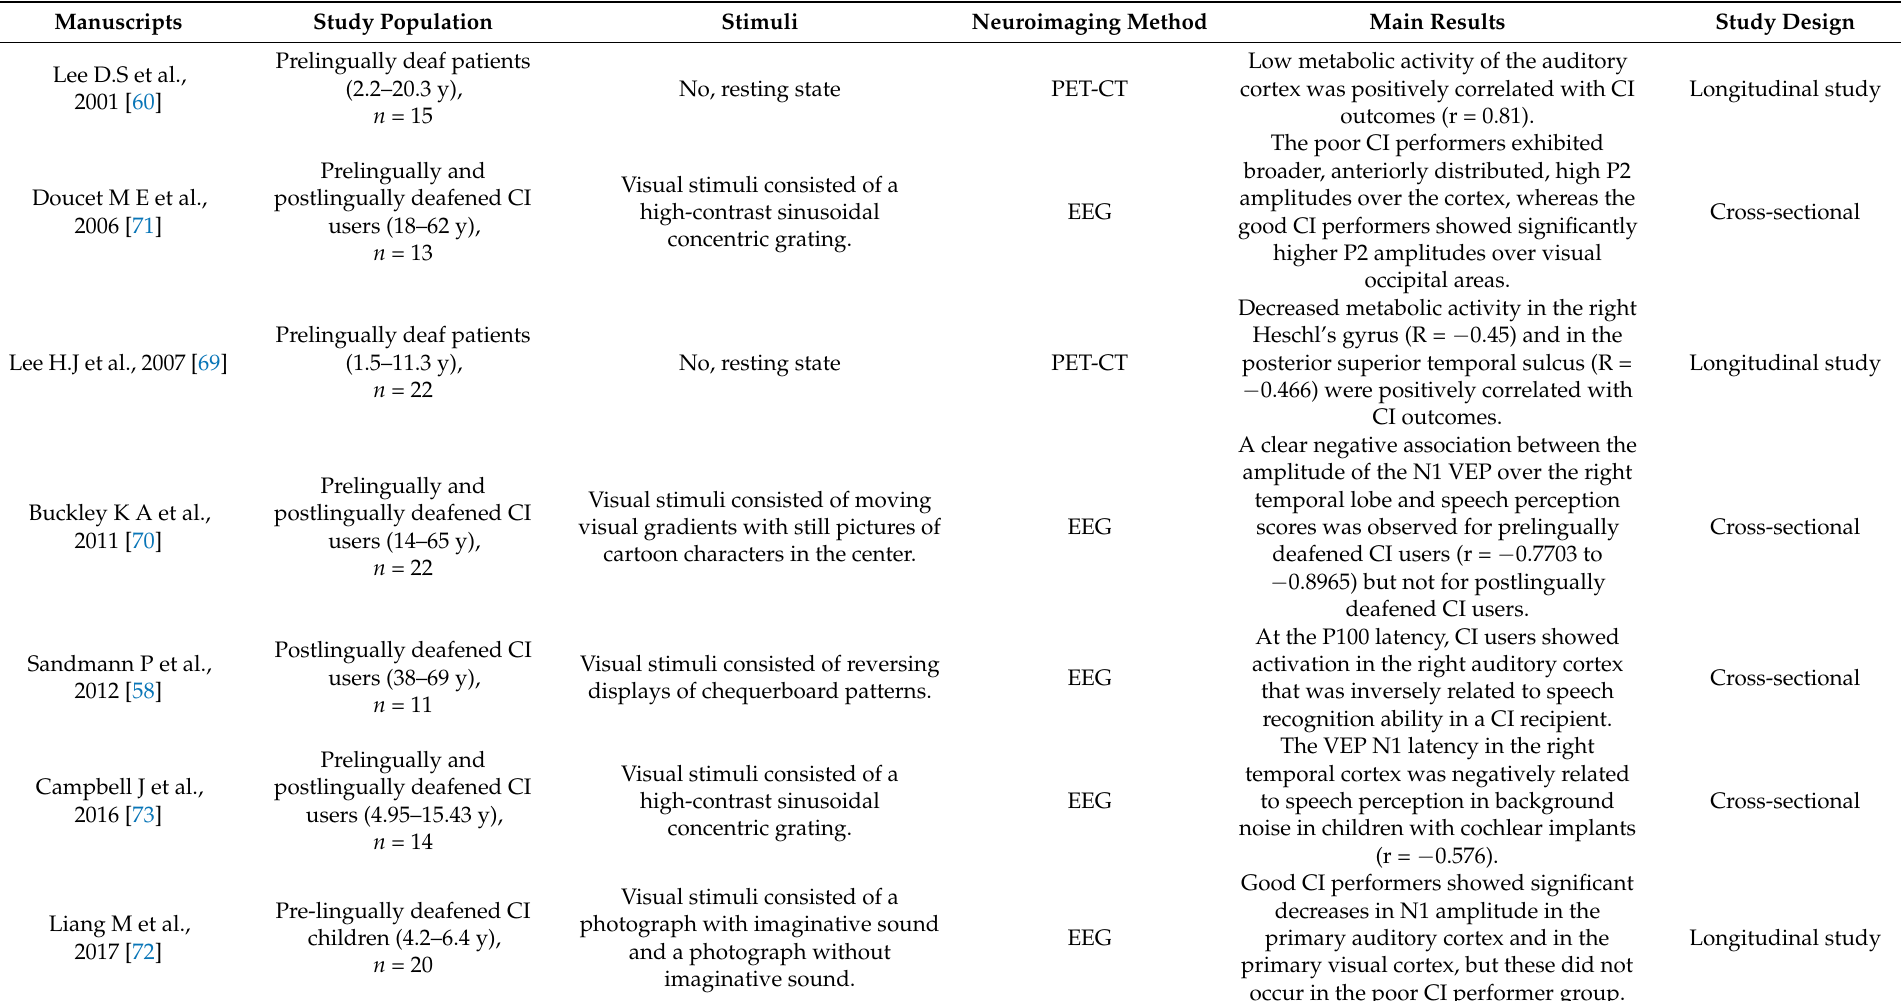
Table 1. Design information and key results from the main studies on the effects of cortical